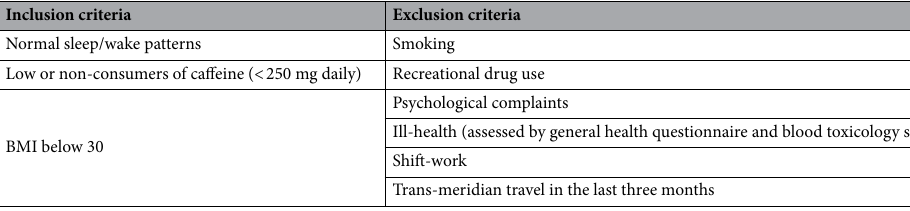
Table 2. Experimental sample characteristics.